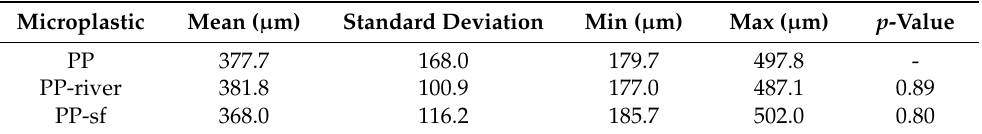
Table 1. µ FT-IR dimensional analysis (mean, standard deviation, minimum and maximum). Com- parison of particles ( n = 20 per group) (Mann-Whitney U test) after pre-treatment in three different solutions. PP denotes polypropylene unconditioned; PP-river polypropylene preconditioned in riverine water; PP-sf polypropylene preconditioned in Triton X-100 solution.